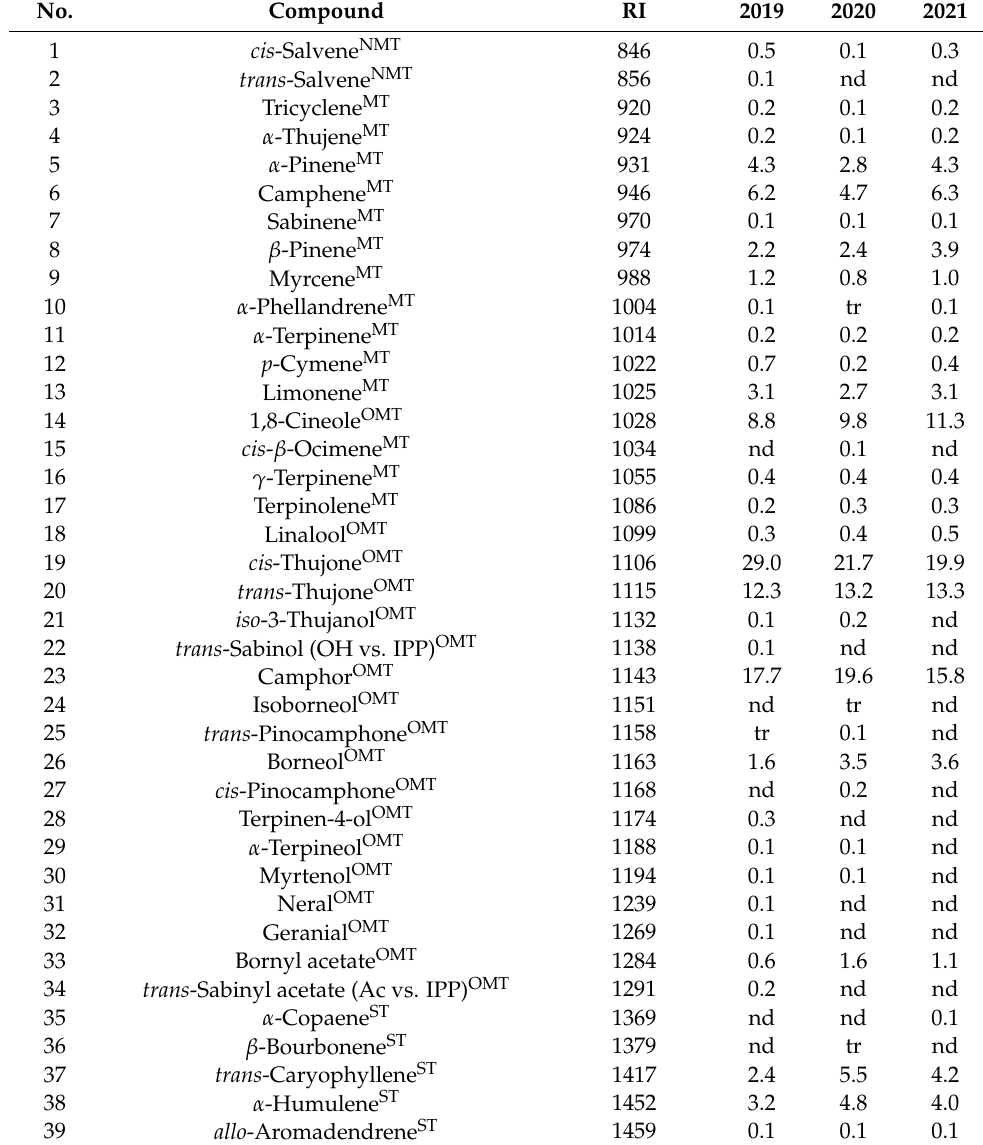
Table 3. Salvia officinalis essential oil chemical